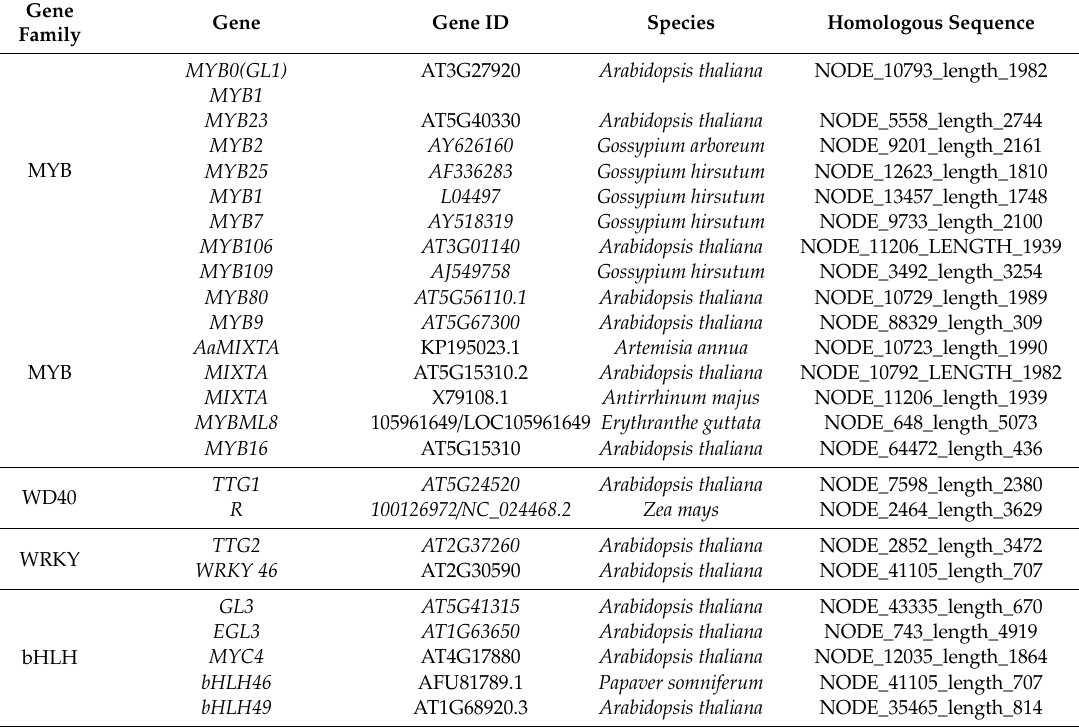
Table 2. Homologous sequences related to trichomes in D.